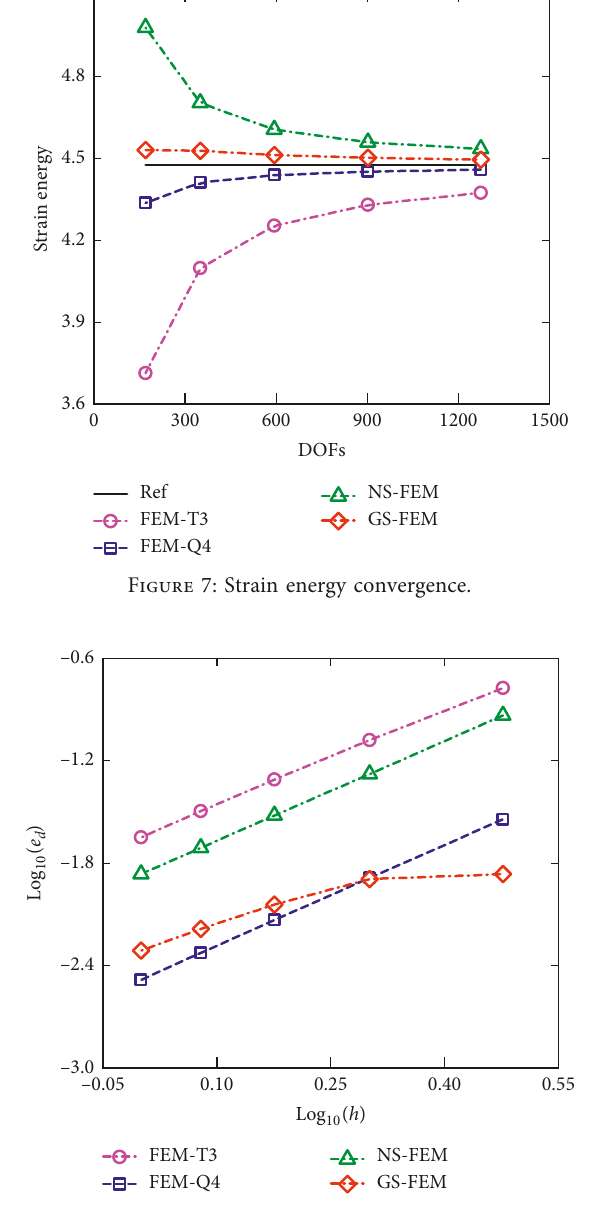
Figure 8: Convergence rate of displacement error norms.